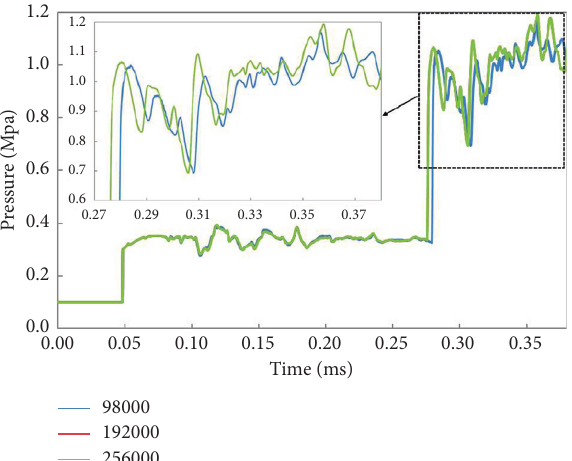
Figure 5: Pressure histories of point 1 for different computational grids.